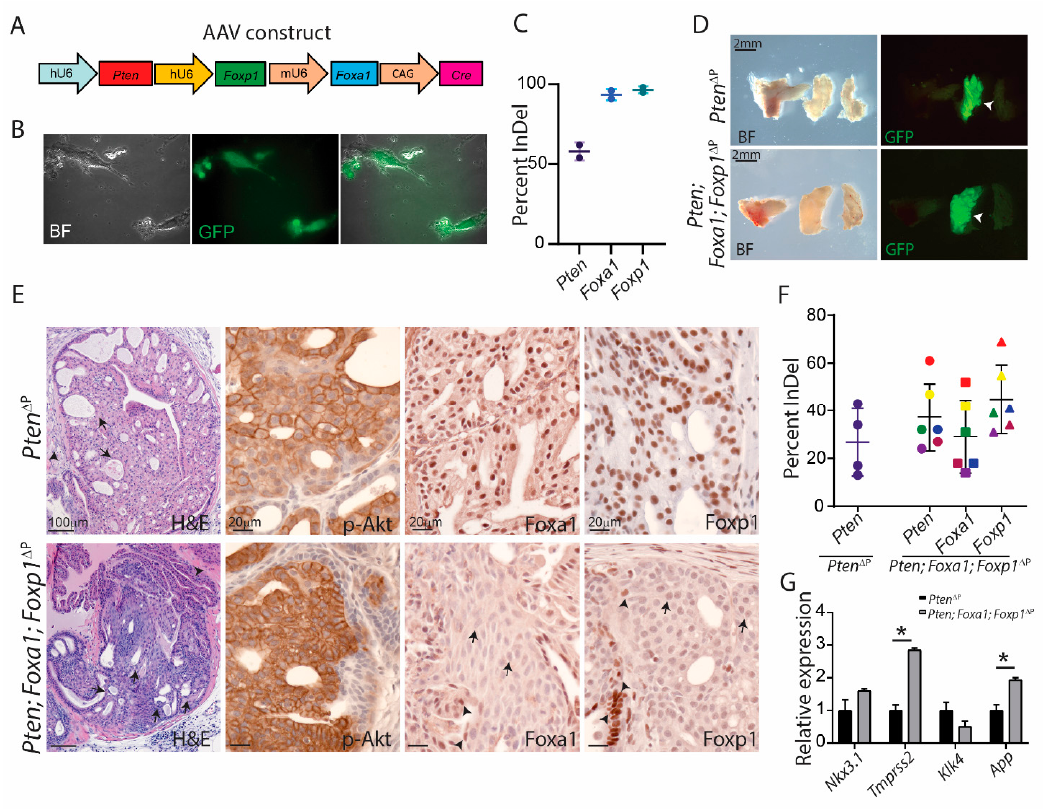
Figure 4. CRISPR-mediated mutations of Foxa1, Foxp1 and Pten in the prostatic epithelium. ( A ) AAV construct for delivery of sgRNAs targeting Pten , Foxa1 and Foxp1 under pol3 promoters. The construct also contained Cre expression by the CAG promotor. ( B ) AAV particles were validated in MEF from Cas9-EGFP flox/flox mice and expression of EGFP could be detected after viral transduction. Images were taken with 10× magnification ( C ) Indel analysis of the target site from the transduced MEF cells ( n = 2). ( D ) Macroscopic pictures of the prostatic lobes 4 months after virus transduction. White arrowheads mark the anterior prostate lobes positive for EGFP expression after virus-mediated Cre expression (representative image, n = 5). ( E ) Paraffin sections from the prostates were stained for H & E (arrowheads mark PIN and arrows mark stromal changes) and antibodies for p-Akt, Foxa1 and Foxp1 (brown stain) ( n = 5). Arrows mark cells depleted for Foxa1 or Foxp1, whereas arrowheads mark positive cells. ( F ) Indel frequency for Pten , Foxa1 and Foxp1 were measured from EGFP-positive biopsies taken from the anterior prostate lobe. Sanger Sequencing data were analysed with Synthego ICE software ( n = 4–6). ( G ) Expressions of AR-regulated genes were measured from Pten and Pten; Foxa1; Foxp1 -deficient samples ( n = 4, * = p < 0.05).